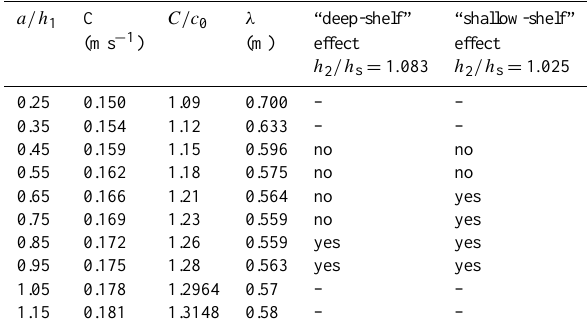
Table 1. “Deep” and “shallow” shelf effect versus parameters of solitary waves generated in the